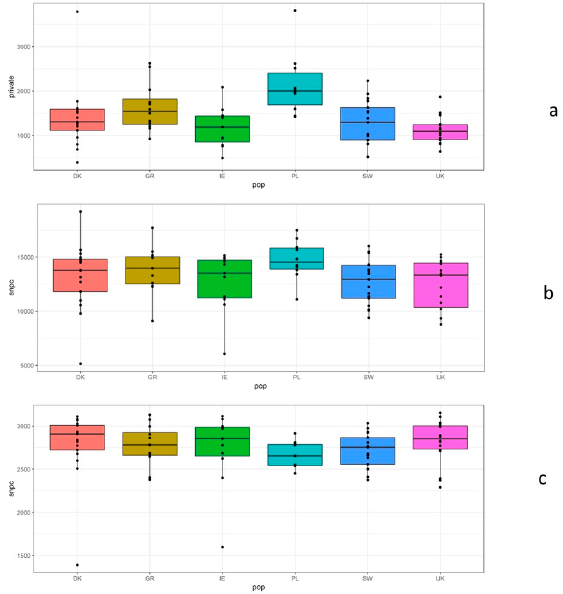
Figure 2. Summary of GBS SNP data grouped by geographic region. ( a ) Number of SNPs with greater than 5% frequency, ( b ) total number of SNPs, ( c ) private SNPs.